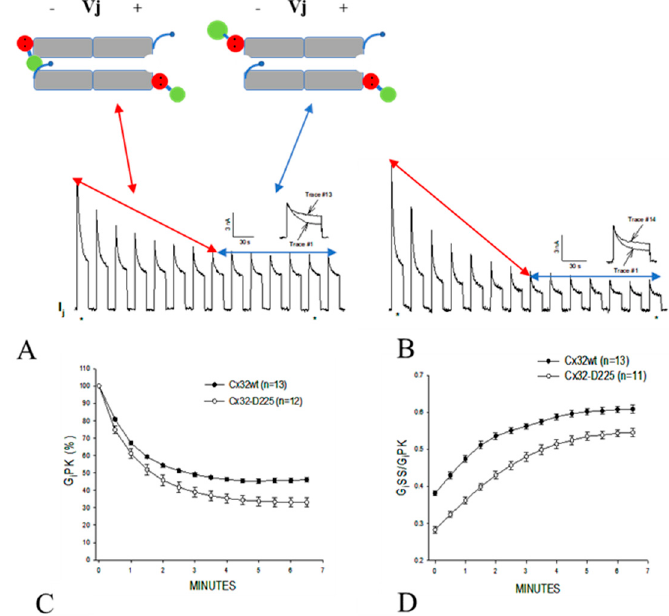
Figure 11. Slow Gj decay in oocytes expressing either Cx32 or its CT-truncated mutant (Cx32-D225) subjected to long − 100 mV Vj pulses. ( A , B ) show junctional current (Ij) tracings recorded from Cx32wt and Cx32-D225, respectively. Note the gradual drop in Ij-Peak (IjPK) and, to a lesser extent, Ij-Steady-State (IjSS; A and B). GjPK drops exponentially by 50–60%, eventually reaching steady state ( C ). GjSS / GjPK increases by 60% and 93% in Cx32wt and Cx32-D225, respectively ( D ). The large drop in Ij during the first 8 pulses is likely to result from the closure of both chemical / slow gate and fast Vj gate (( A , B ) double-headed red arrows and left drawing). The Ij behavior of the following 6 Vj pulses is likely to reflect the closure of only the fast Vj gate of the remaining open channels (( A , B ) double-headed blue arrows and right drawing). From [82].